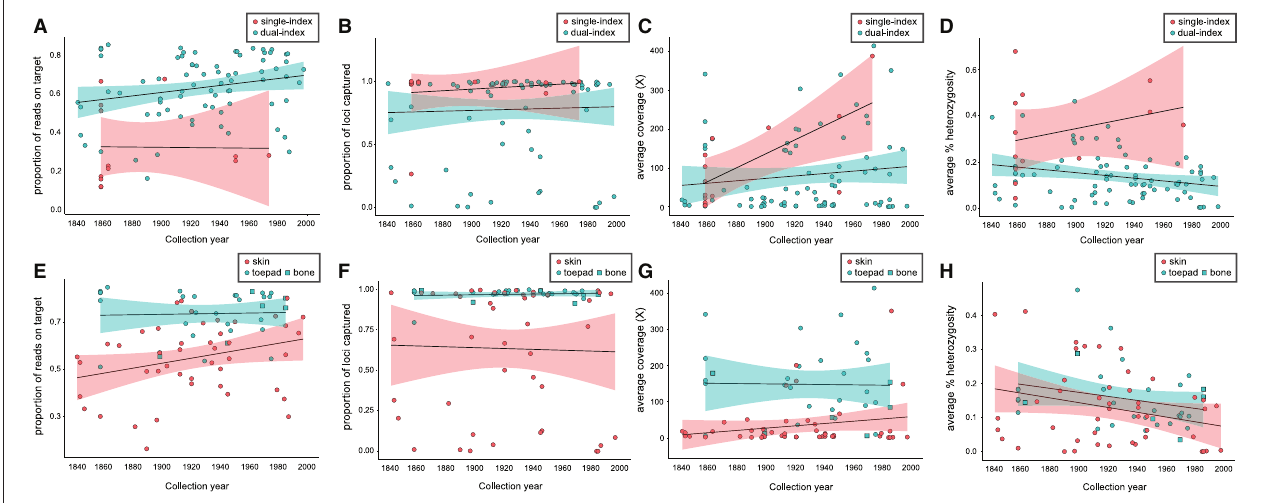
FIGURE 1 | Relationship between year of specimen collection and indexing strategy for (A) proportion of reads on target, (B) proportion of targeted loci captured, (C) average coverage, (D) average percent heterozygosity, and for dual-indexed samples only; between year of specimen collection and tissue type for (E) proportion of